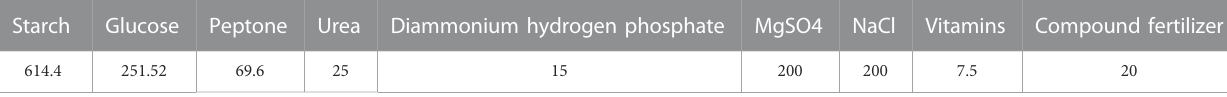
TABLE 1 Arti fi cial bio-organic water ration (unit: g). Starch Glucose Peptone Urea Diammonium hydrogen phosphate MgSO4 NaCl Vitamins Compound